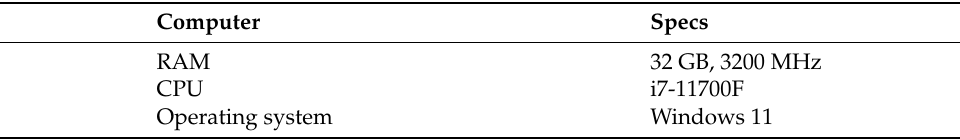
Table 11. The computer specifications.